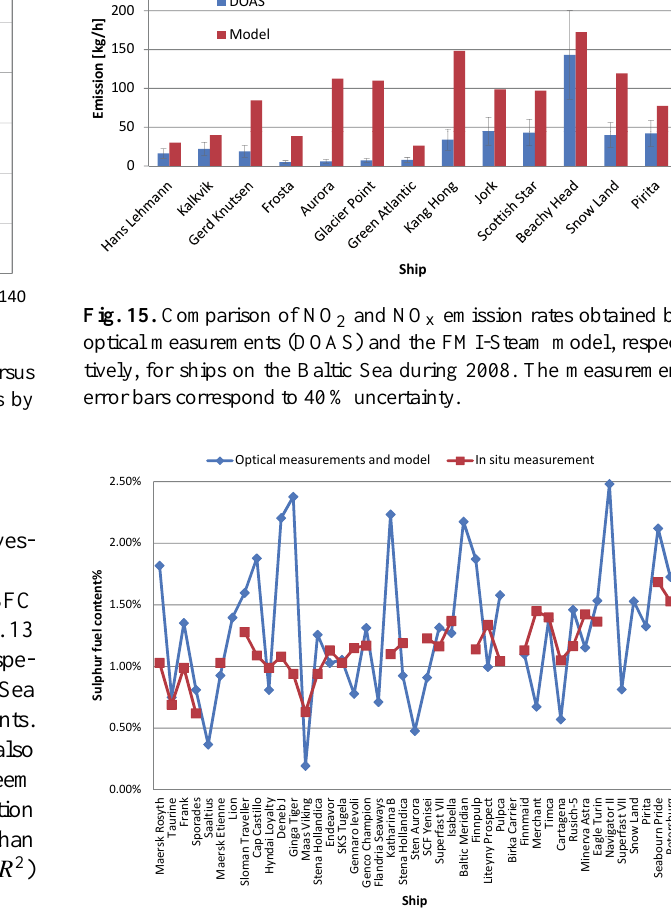
Fig. 16. Sulphur fuel content obtained by combining the optical SO 2 emission measurement with modelled power consumption and in situ measurements of SFC by conventional technique. The data cor- respond to ships measured on the Baltic and North Sea during 2008 and 2009,